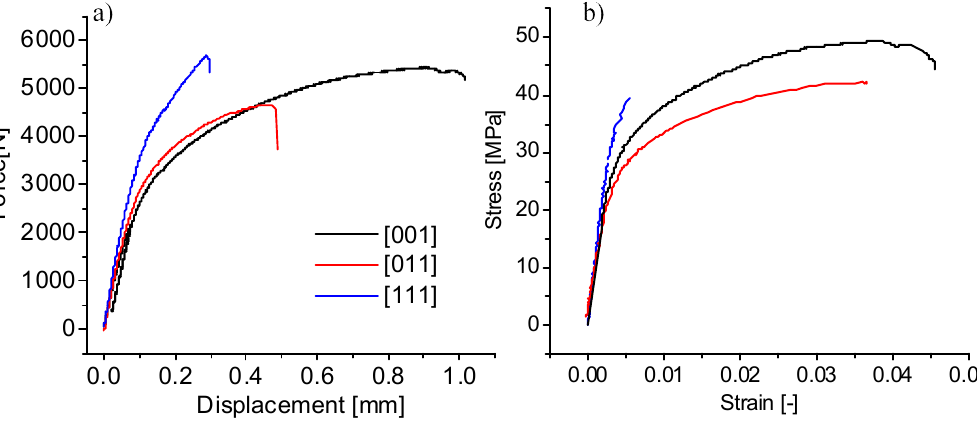
Figure 11. Tensile testing of lattice specimens with three cell orientations: ( a ) force–displacement and ( b ) stress–strain diagrams.